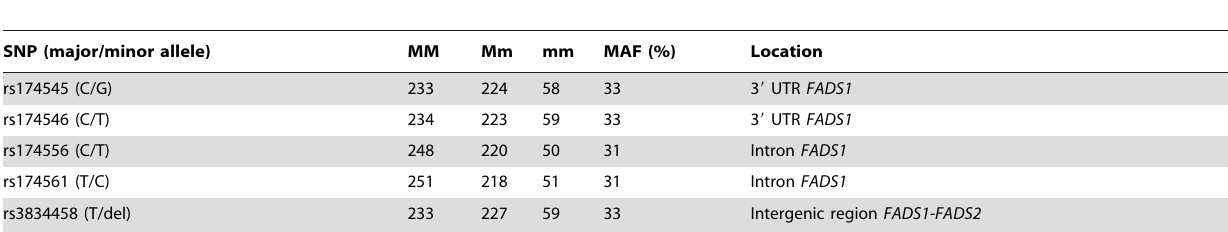
Table 5. Genotype frequencies, minor allele frequencies (MAF), and location of the studied single nucleotide polymorphisms